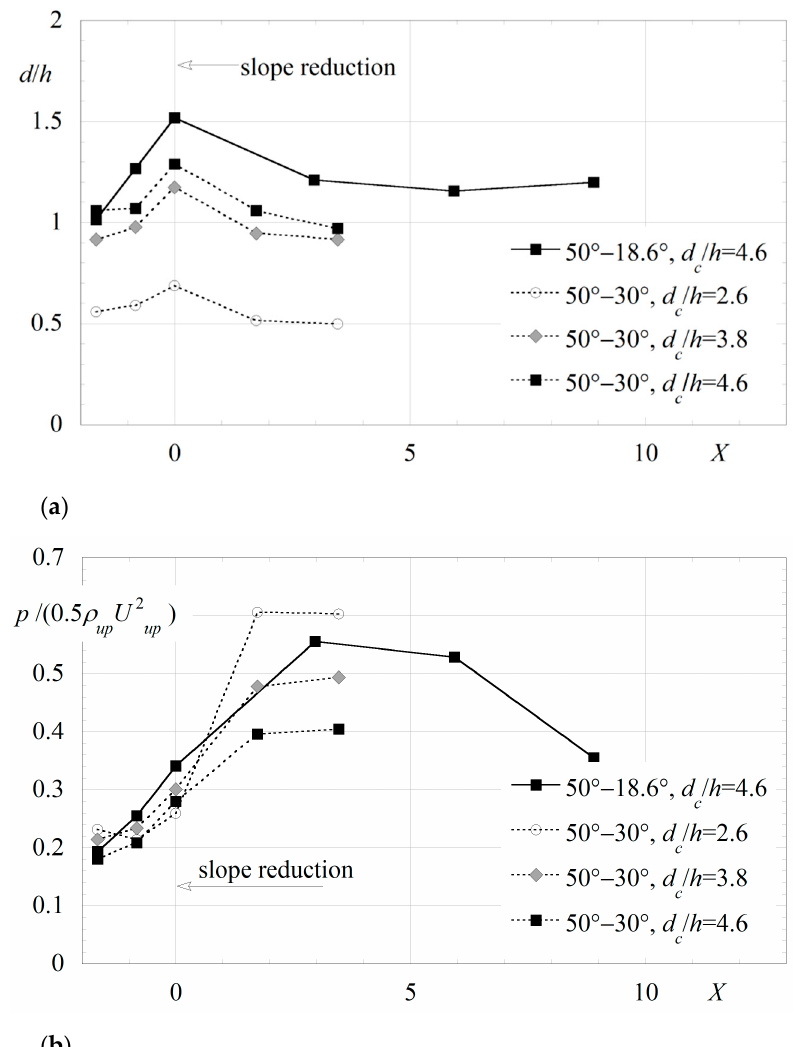
Figure 7. Streamwise development of the ( a ) normalized equivalent clear-water depth d / h and ( b ) normalized mean pressure p /(0.5 ρ up U 2 up ) on the horizontal step faces, at x / l =0.35, 0.17, and 0.3, respectively, on the 50°, 30°, and 18.6° sloping chutes.